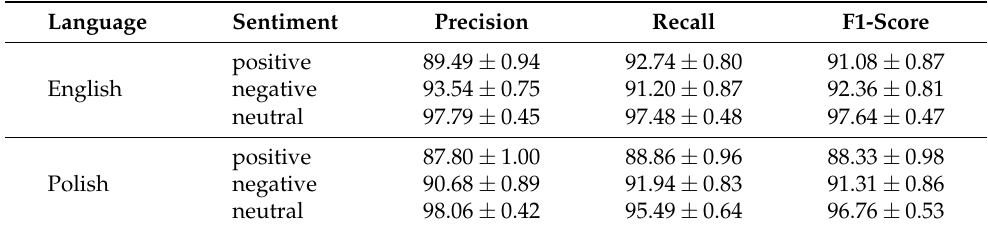
Table 3. Evaluation metrics (in percentages) for sentiment classification with BERT model for test subsets, for both languages. Confidence intervals given for confidence level 90%.